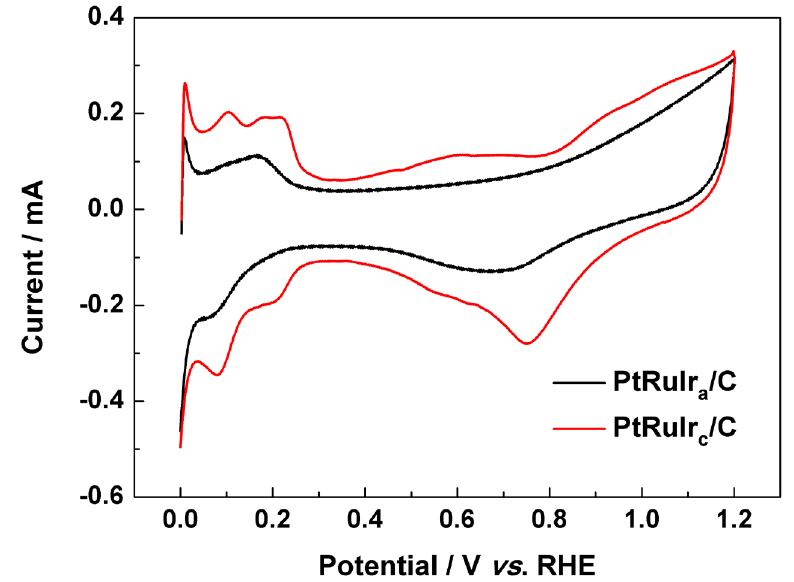
Figure 3. Cyclic voltammograms of PtRuIr H SO solution under N 2 4